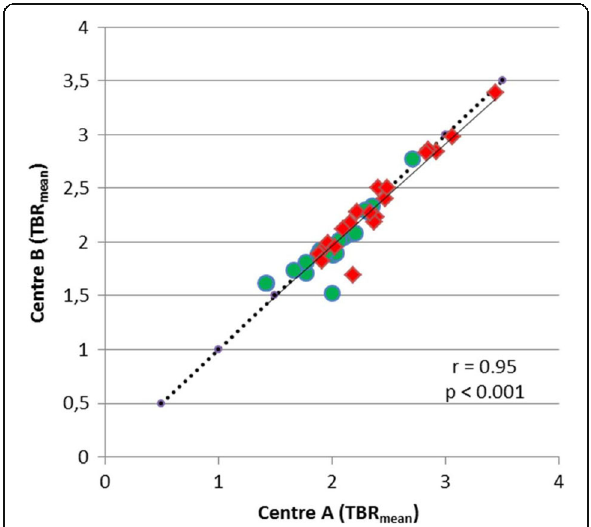
Fig. 4 Correlation of TBR max from centres A and B . There is a significant correlation but a deviation from line of unity indicating higher TBR max values for centre B . High-grade tumours are indicated by red symbols and low-grade tumour by green symbols